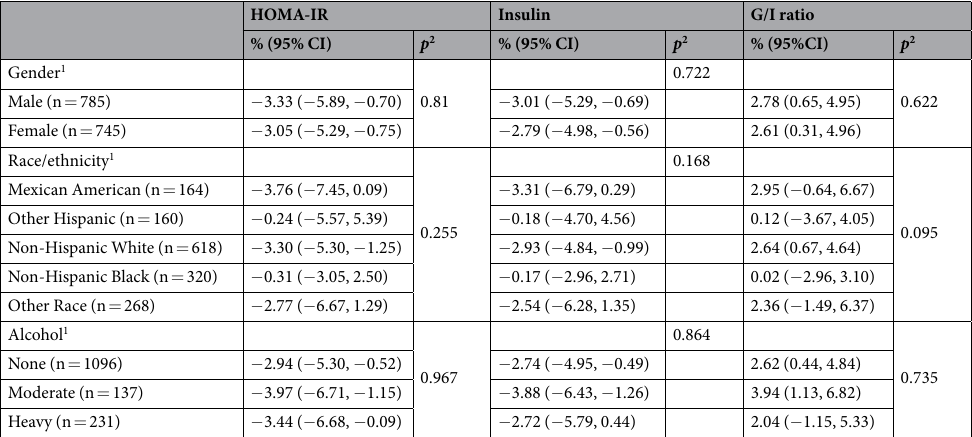
Table 3. Percentage Change (95%CI) in Insulin Resistance/Sensitivity Associated with a 25% Increase in Serum Folate Concentrations among U.S. Nondiabetic Adults, stratified by gender, race/ethnicity, and alcohol consumption, NHANES 2011–2012. 1 based on Model III. 2 p value of Interaction between serum folate and